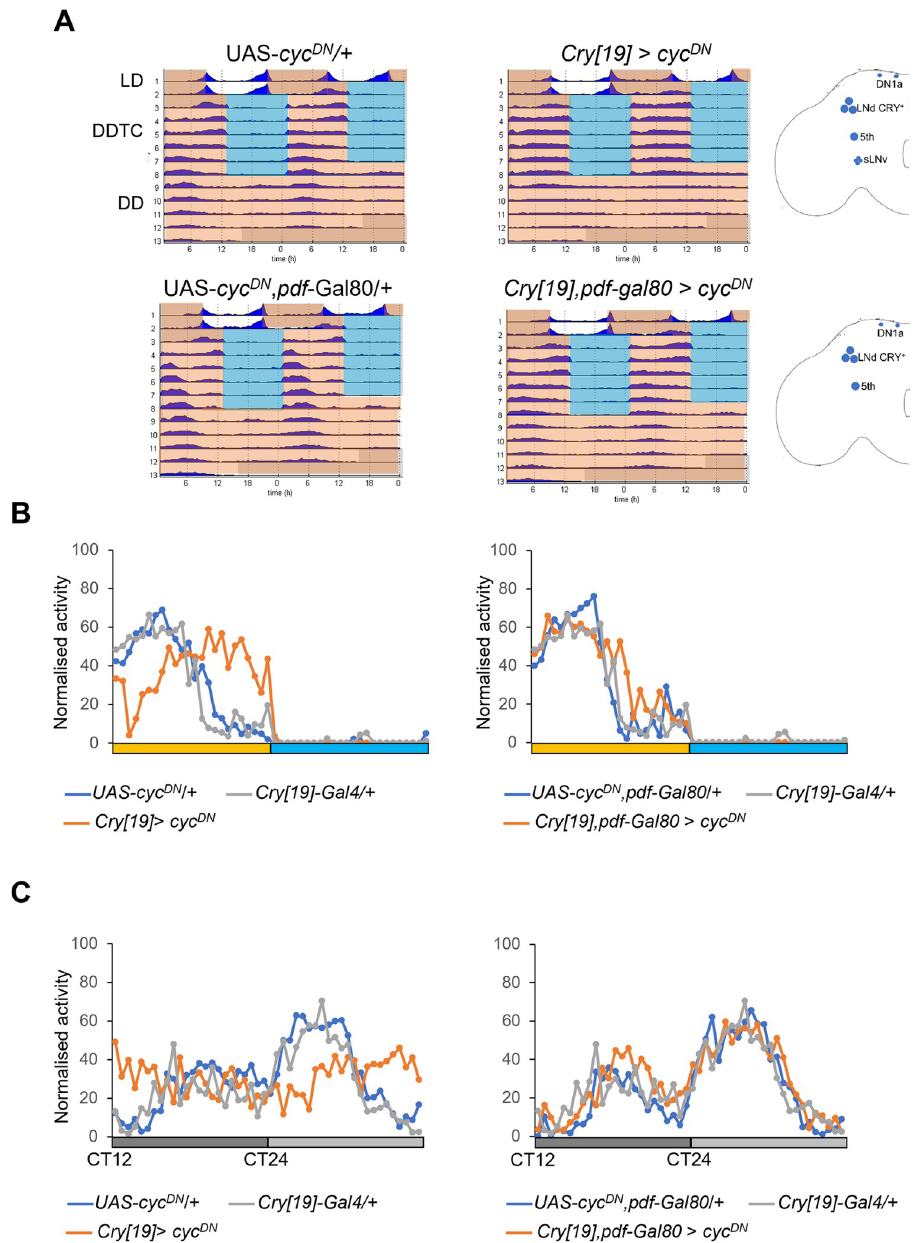
Fig 5. Clock function in the MO and EO neurons is not required for synchronization to temperature cycles in constant darkness (DDTC). A) Double plotted average actograms of the indicated genotypes. N: UAS-cyc DN /+ = 25, cry[19] > cyc DN = 30; UAS-cyc DN , pdf-Gal80/+ = 21; cry[19] , pdf-Gal80 > cyc DN = 25. Conditions are indicated to the left. White areas indicate lights on and 25˚C, orange areas lights off and 25˚C, blue area light off and 16˚C. Cartoons to the right indicate clock neurons expressing cyc DN in the respective genotypes. B-C) Median of normalized locomotor activity during the 6 th day of DDTC (B), and the first two DD days in constant conditions (C). Same flies as in A. The dark grey bars represent the subjective night of DD1, the light grey bars subjective day of DD2. fruit flies lose their two anticipatory activities present in LD 25˚C at different constant temper- atures. At warm temperature ( � 30˚C), flies only anticipate the light-on transition while at colder temperatures ( < 20˚C) they only anticipate the lights-off [41]. On the other hand, when